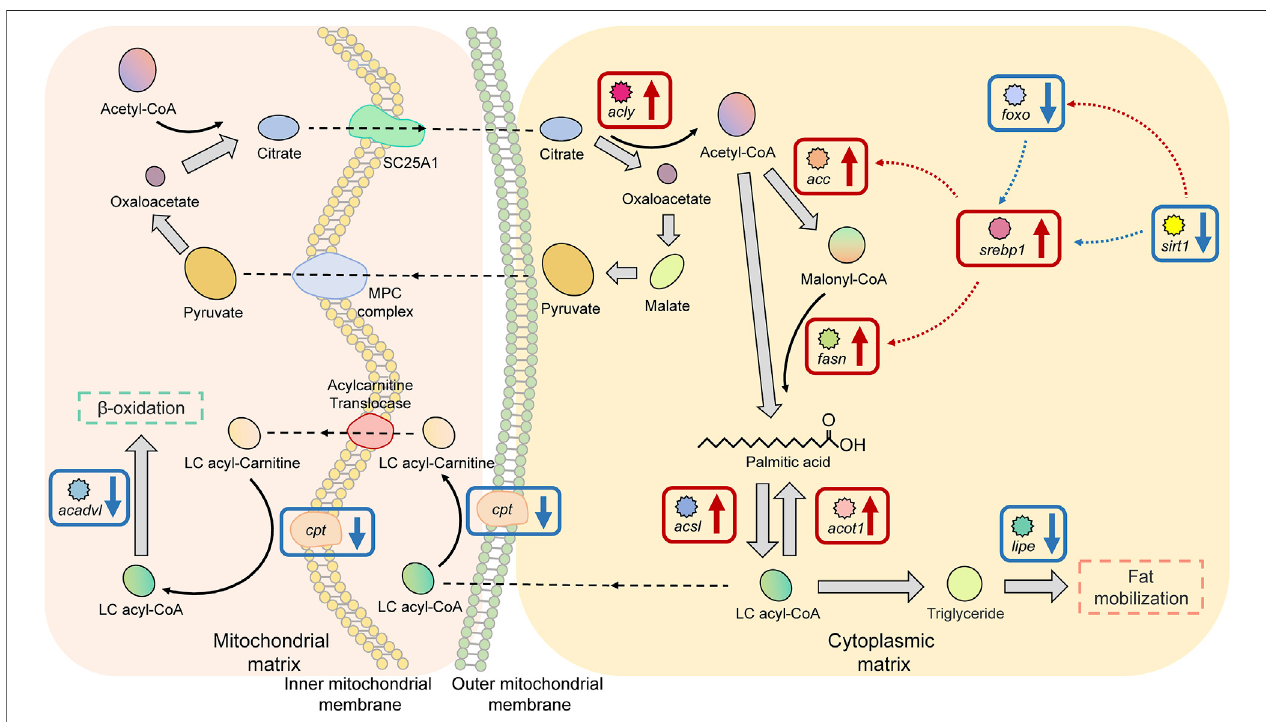
FIGURE 7 | Key factors of the “ fatty acid biosynthesis and metabolism pathway ” in superior growth performance Nile tilapia. Red boxes mark upregulated genes, and blue boxes mark downregulated genes. Genes encoding key enzymes involved in the ß -oxidation pathway ( cpt , acadvl ) were downregulated, and genes encoding key enzymes involved in fatty acid biosynthesis and activation ( acly , acc , srebp1 , fasn , acsl , and acot1 ) were upregulated.